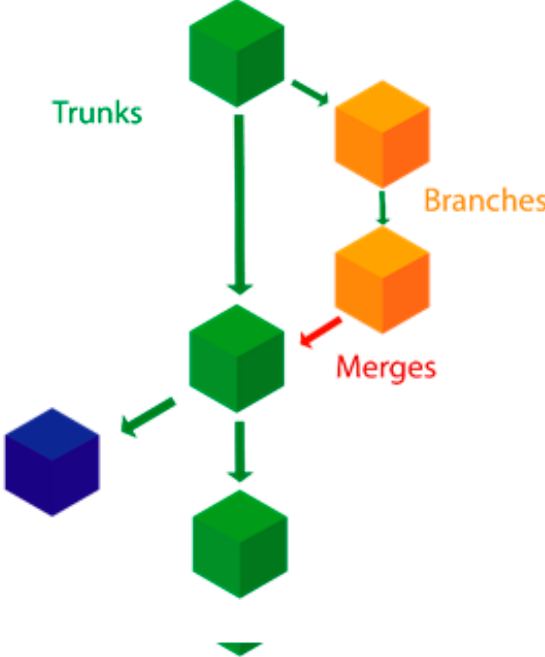
Figure 5. Blockchain-based version control system.